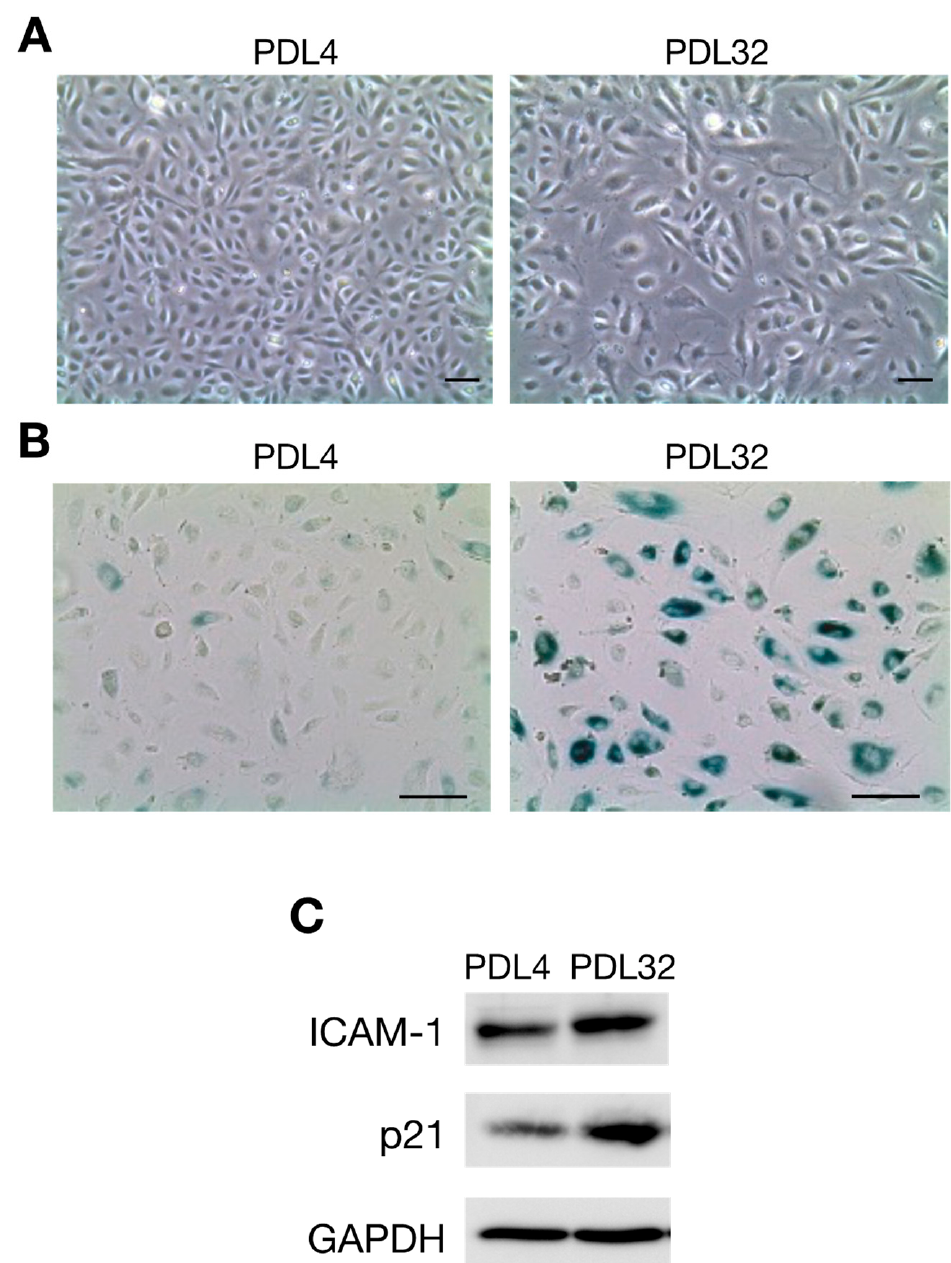
Figure 1. The characteristics of senescent endothelial cells prepared by the serial passage of human umbilical vein endothelial cells (HUVECs). HUVECs were cultured in endothelial cell growth media in 10 cm-diameter dishes and then passaged every 3 or 4 days. ( A ) Phase contrast images of population doubling level 4 (PDL4) (left) and PDL32 (right) cells are shown. PDL is defined as the total number of times that the cells in the population have doubled. PDL32 cells have an enlarged and flattened morphology (original magnification ×50). ( B ) Images showing SA- β -Gal staining with PDL4 (left) and PDL32 (right) cells. SA- β -Gal activity is increased in the PDL32 cells (original magnification ×100). ( C ) The expression of ICAM-1 and p21/WAF-1 in PDL4 and PDL32 cells was evaluated by Western blotting. Images are representative of three independent experiments. Glyceraldehyde 3-phosphate dehydrogenase (GAPDH) expression was detected as an internal control. Scale bars, 100 µm [93].